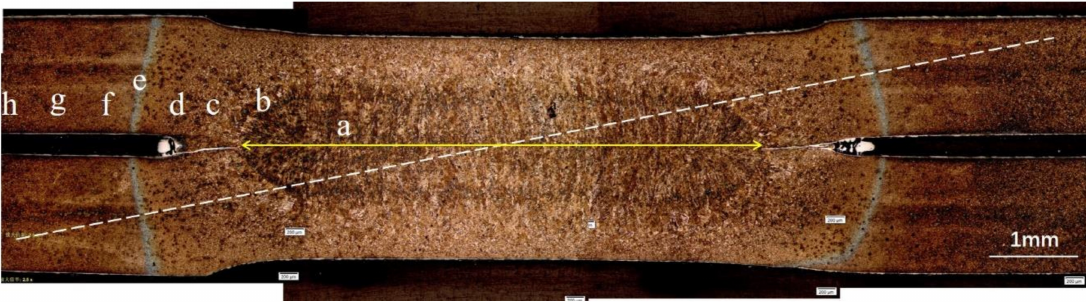
Figure 5. Low-magnification optical microstructure of a whole spot welding joint obtained at AC-6, with a peak current of 12 kA, frequency of 110 Hz, and welding time of 35